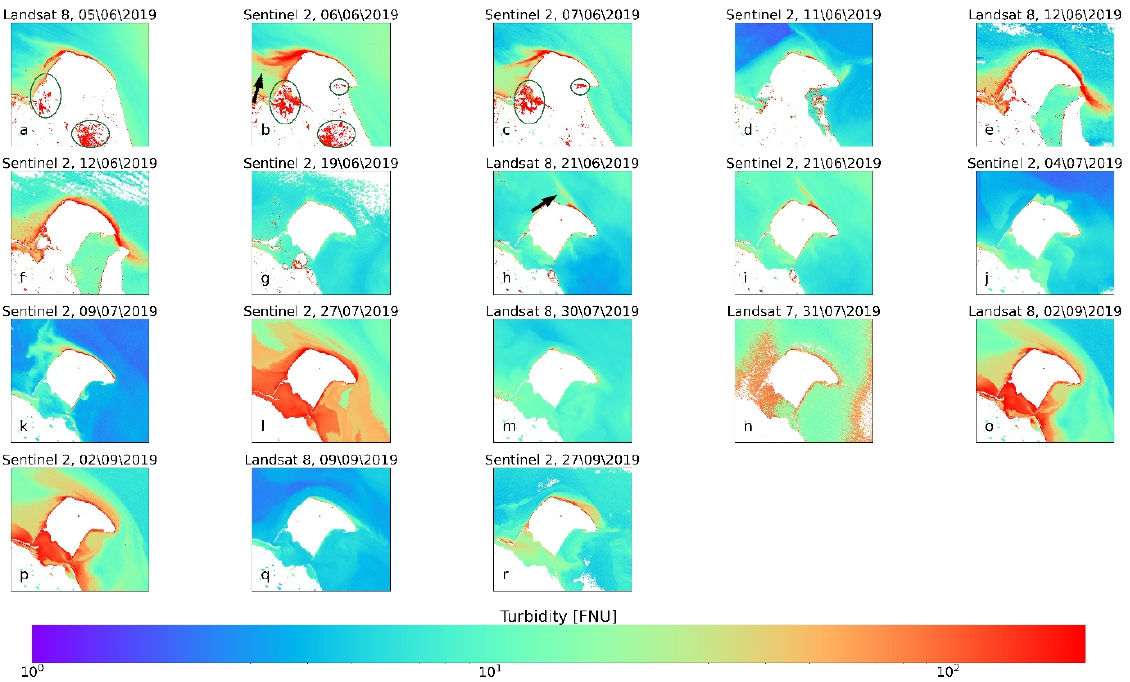
Figure 2. Time series of satellite imagery from the summer season of 2019. Highlighted green areas mark areas of water–ice interactions and, thus, potential mistakes within the atmospheric correction. Black arrows highlight sediment transport off the coastline. Figures a – f depict the ice break-up with increased turbidity. During mid-Summer (Figures g – n ), turbidity is decreased with one exception (l). During Fall (Figures o – r ), the turbidity features are unstable and change rapidly.